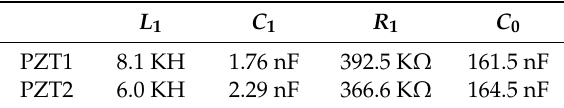
Figure 4. Waveform characteristics of the PZTs: ( a ) phases, ( b ) impedances as a function of the frequency. Table 2. Parameters of PZT1 and PZT2.